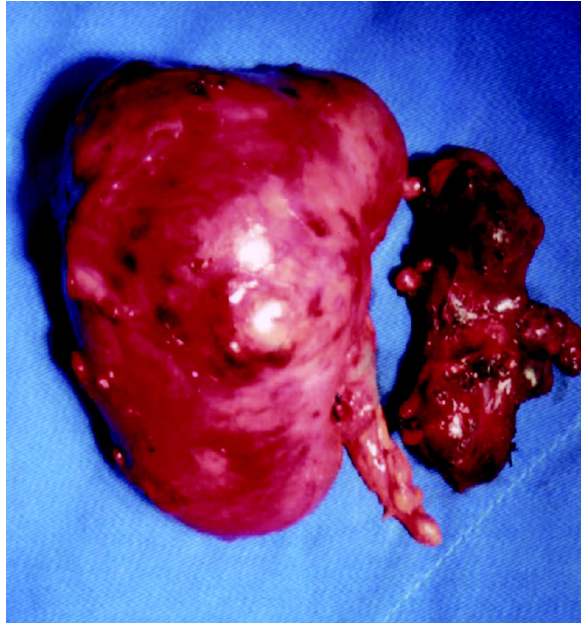
Figure 2 – Surgical specimen from right radical nephrectomy and regional lymphadenectomy.